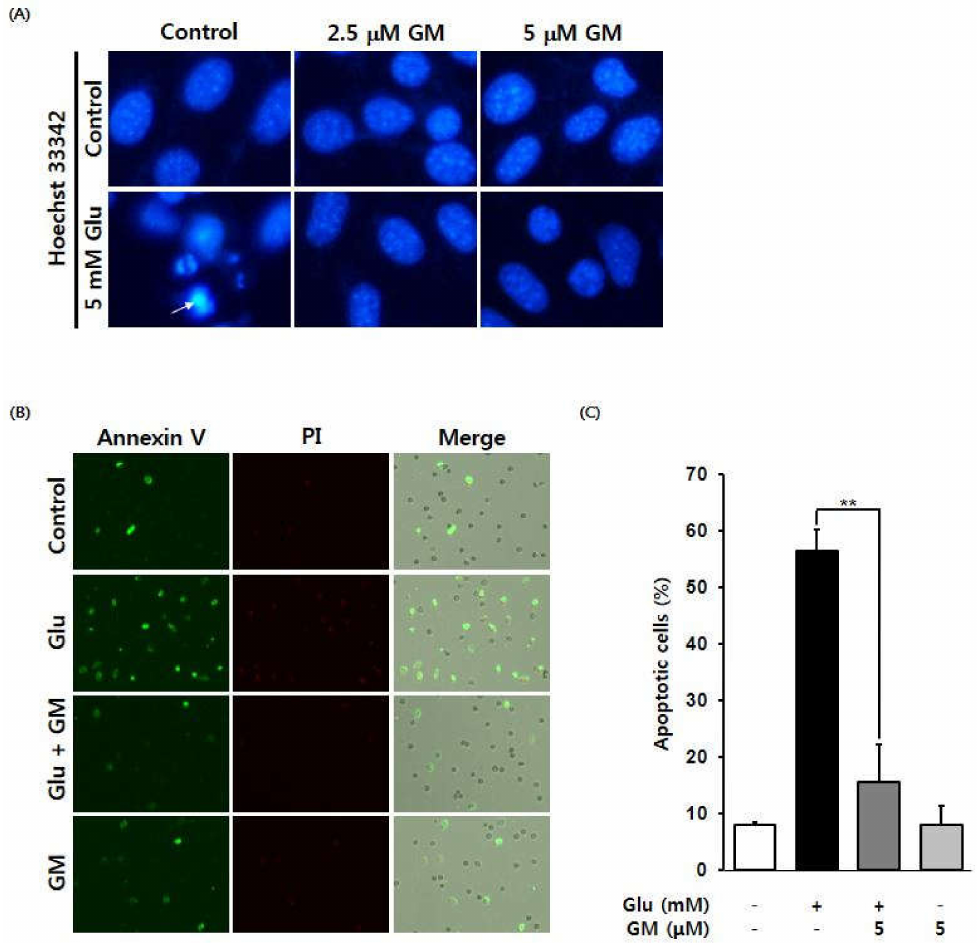
Figure 3. Effect of γ -mangostin (GM) on glutamate (Glu)-induced apoptotic cell death in HT22 cells. ( A ) Inhibitory effect of GM on Glu-induced chromatin condensation in HT22 cells. GM reduced Glu-induced annexin V-positive cells; annexin V-positive cells appear green. ( B ) The effect of GM on apoptosis was measured by fluorescence imaging using a Tali-Image-based cytometer. ( C ) Quantitative representation of the effect of GM on the proportion of apoptotic cells (annexin V-positive cells). Cells were treated with 5 mM Glu and 2.5 or 5 µ M GM for 12 h and were then stained with Hoechst 33342. Images were obtained using a fluorescence microscope (20 × magnification). Fluorescent images of cells stained using annexin V (green) and PI (red) and a merged image (bottom). The proportion of apoptotic cells was quantitatively analyzed to confirm the effect of GM (mean ± SEM, ** p < 0.01 compared to Glu-treated